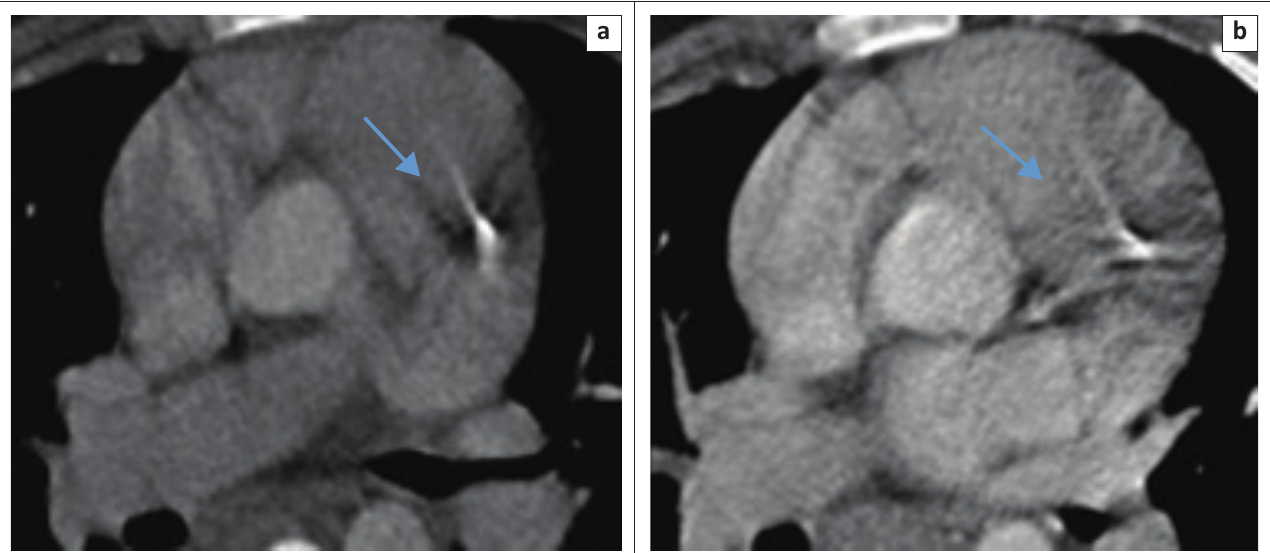
FIGURE 4: Post-contrasted axial images (a & b) at different levels showing calcifications along the left anterior descending coronary artery as indicated by the